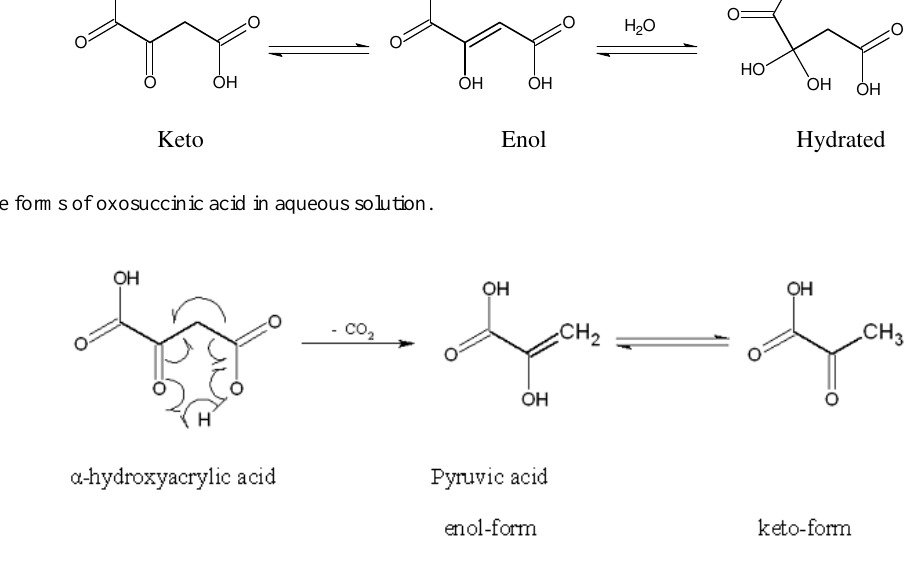
Fig. 3. Decarboxylation of oxosuccinic